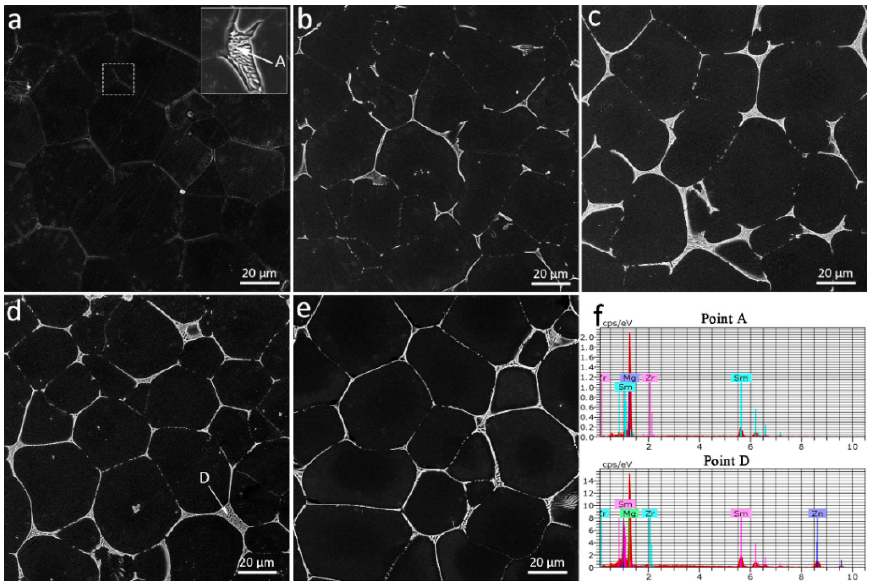
Figure 3. The scanning electron microscope (SEM) micrographs of as-cast Mg–4Sm– x Zn–0.5Zr alloys: ( a ) x = 0; ( b ) x = 1; ( c ) x = 2; ( d ) x = 3; ( e ) x = 4. The hollow rectangle at top-right corner in Figure 2a is the magnifying picture at grain boundary.